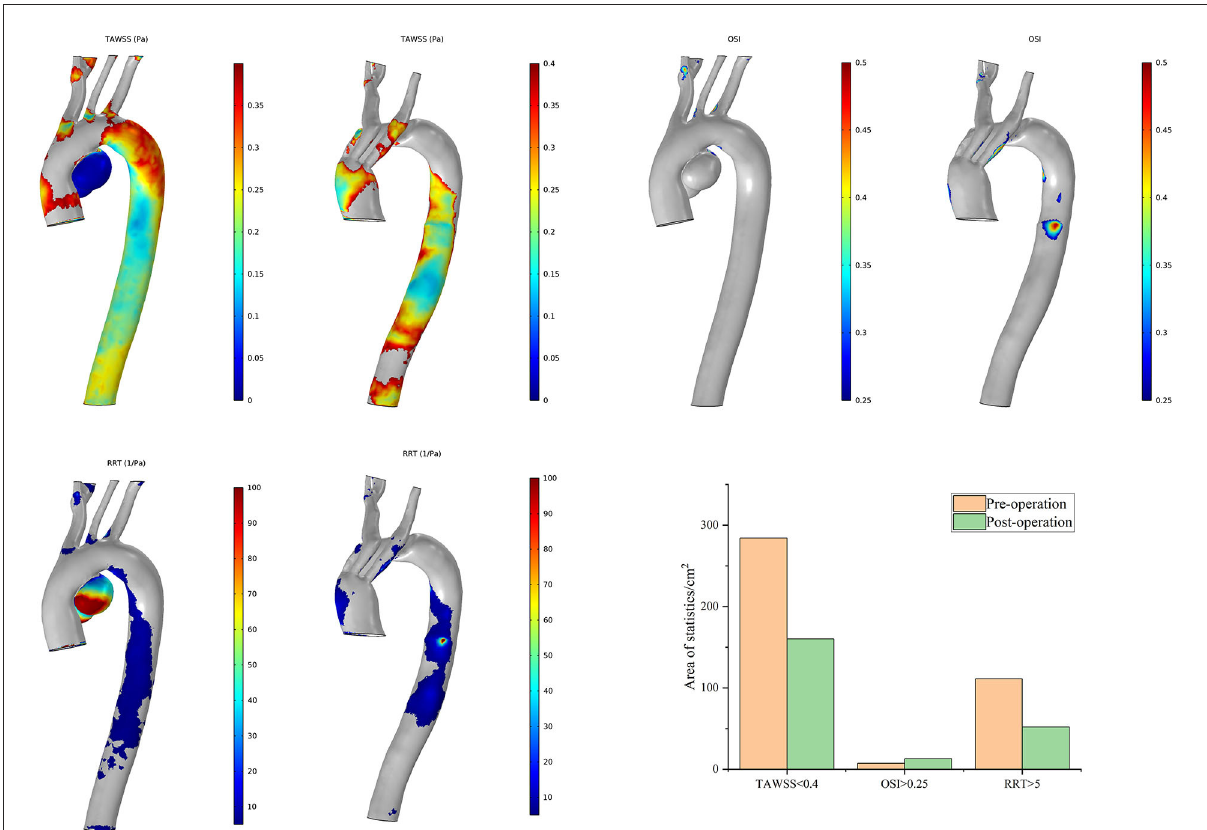
FIGURE8 Distributions of changes in TAWSS, OSI, and RRT in Case 2. The hemodynamic characteristic regions are visually illustrated as a color distribution nephogram with each indicator in a group (left, preoperative; right, postoperative). Areas were calculated and illustrated in the bar graph. OSI, oscillatory shear index; RRT, relative residence time; TAWSS, time-averaged wall shear